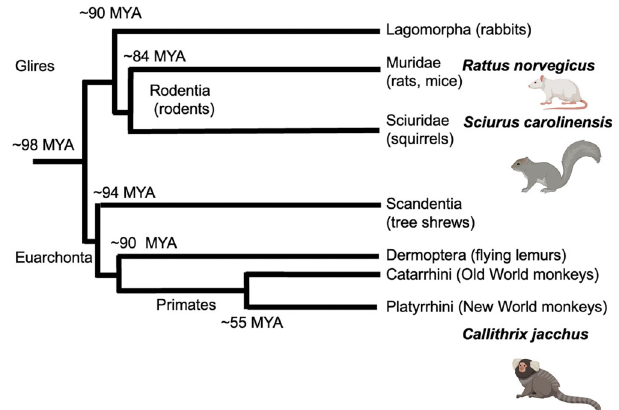
Fig. 1 Phylogenetic tree showing the timelines of divergence (MYA: million years ago) and lineage of rats ( Rattus norvegicus ),